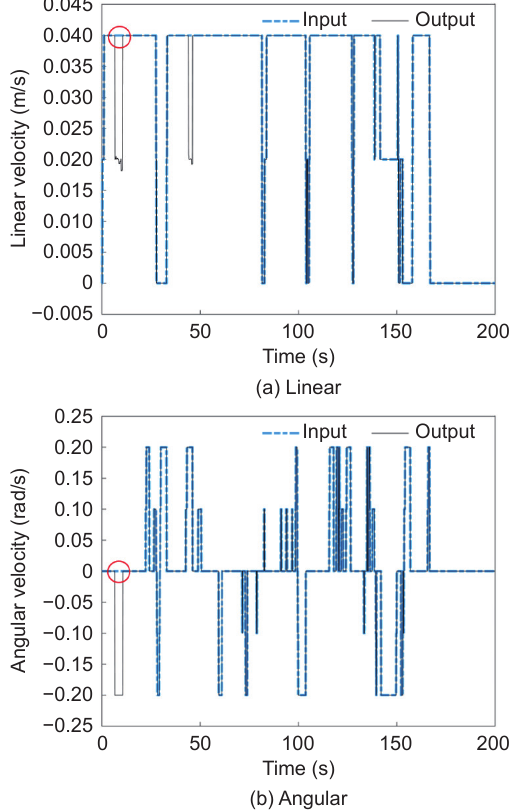
Fig. 9 Input and output linear and angular velocity profiles of the leader controller in the navigation stage for a